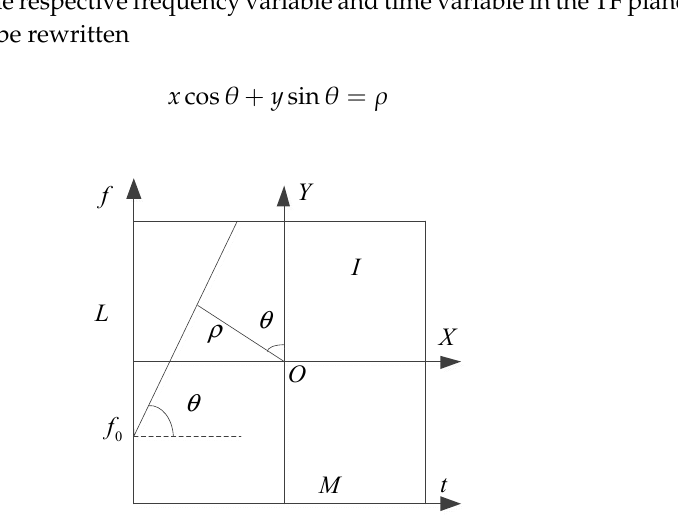
Figure 2. Hough transform diagram.